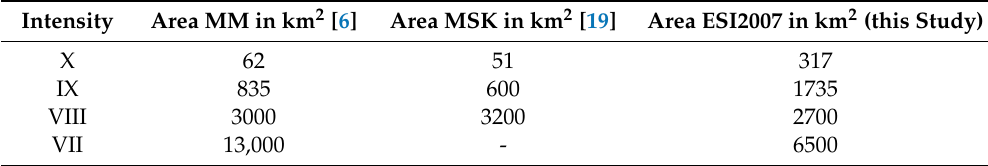
Table 1. Comparison of the intensity distribution of the 1992 Suusamyr Earthquake. Intensity Area MM in km 2 [6] Area MSK in km 2 [19] Area ESI2007 in km 2 (this